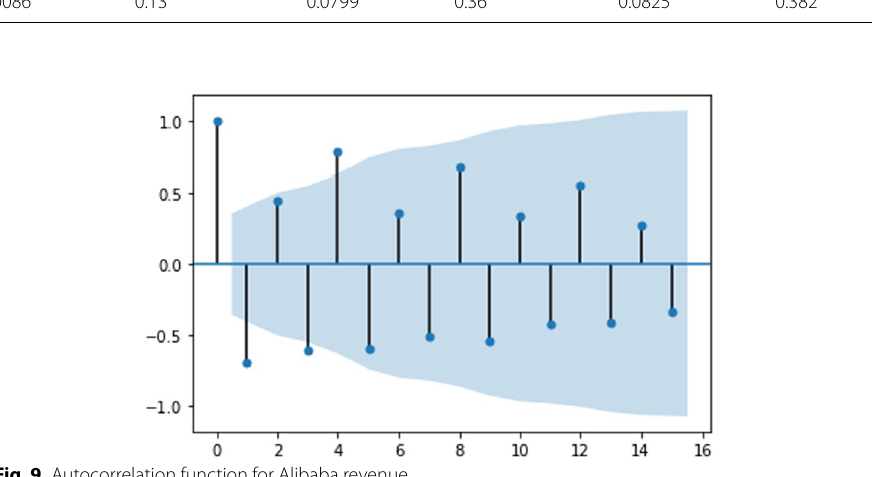
Fig. 9 Autocorrelation function for Alibaba revenue